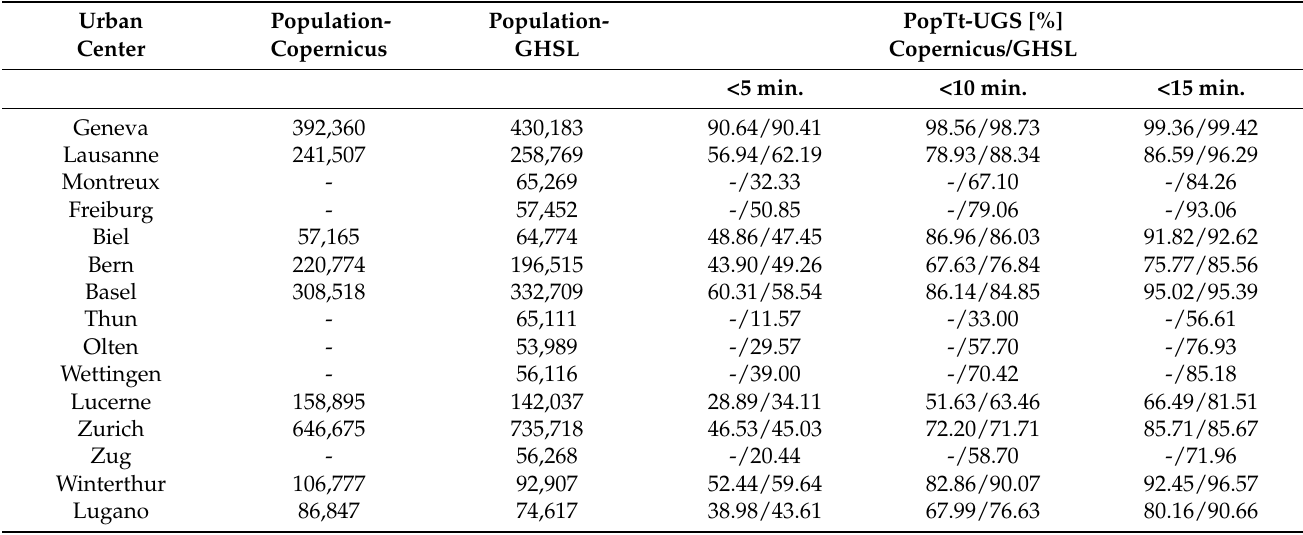
Table 5. Percentage of population that have access to an urban green space, using their centroid and the anisotropic walking-only model (PopTt-UGS) for urban footprints provided by Copernicus and